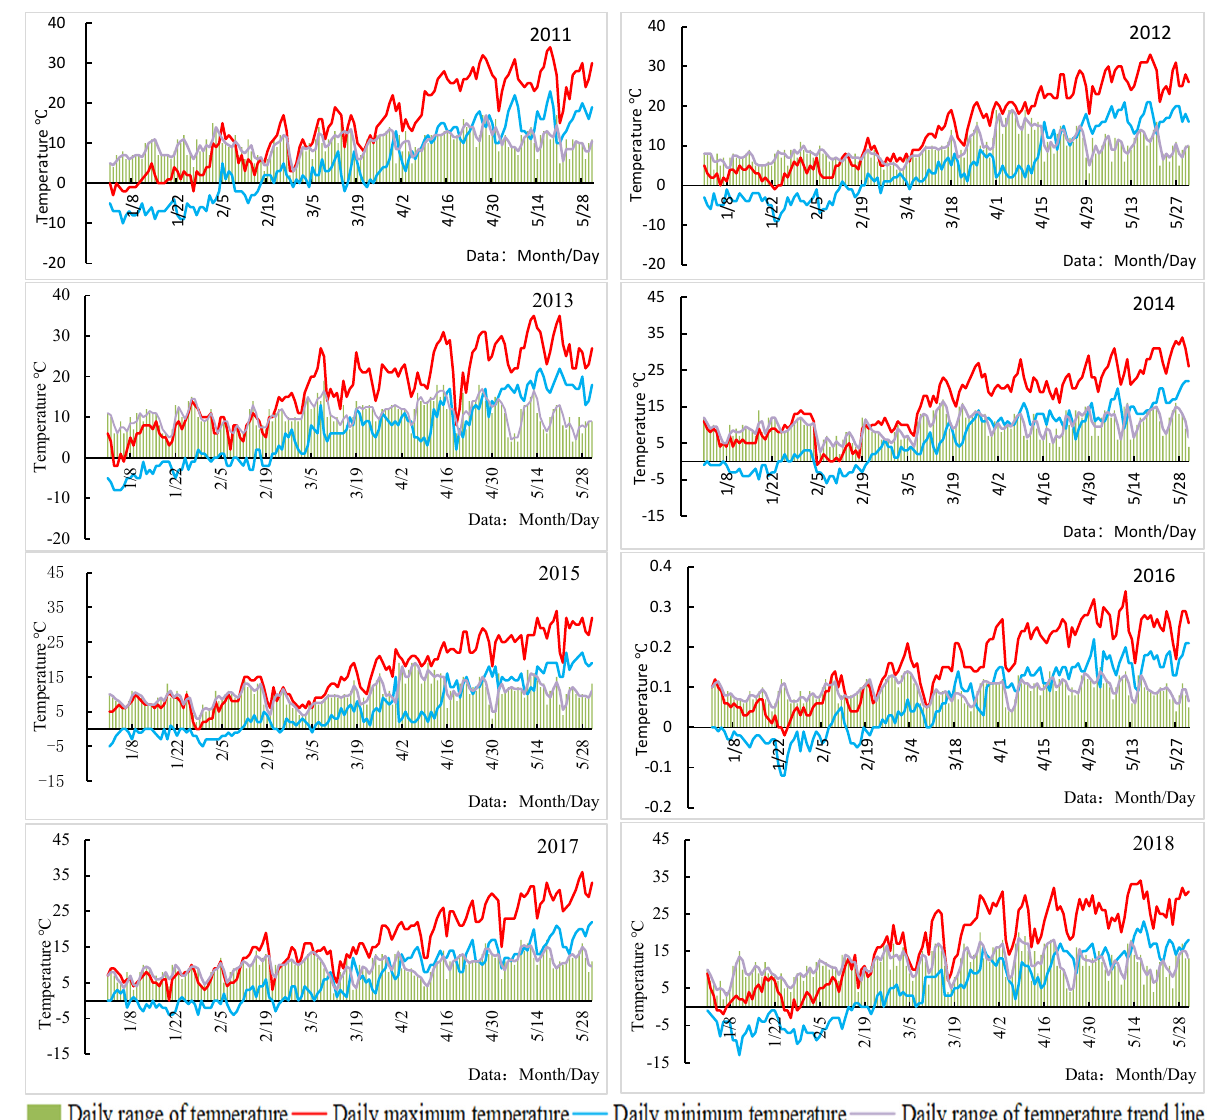
Figure 7. Daily maximum temperature, daily minimum temperature, and daily temperature ranges from January to May in 2011–2018.